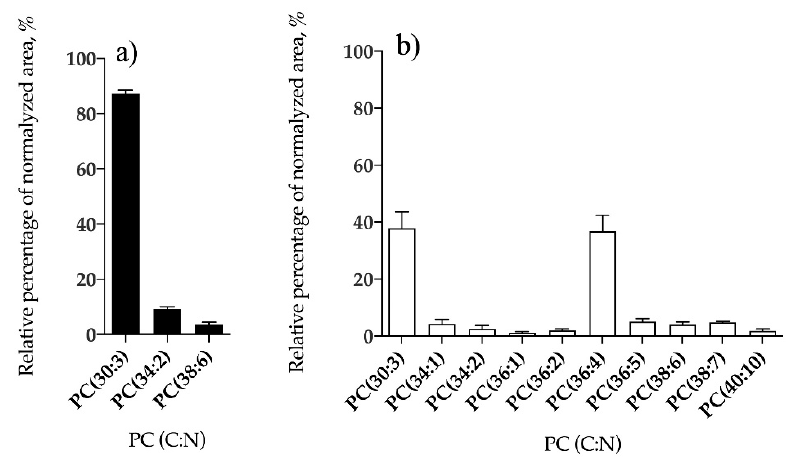
Figure 7. Relative abundance (RA) of lipid species of the phosphatidylcholine (PC) class identified in B. bifurcata ( a ) and S. muticum ( b ). The results are expressed as relative percentage after dividing the normalized peak area of each lipid species to the sum of normalized peak areas for all the lipid species within the class obtained after LC–MS analysis. Numbers in parentheses (C:N) indicate the number of carbon atoms (C) and double bounds (N) in the fatty acid side chains. The species with higher RA were PC (30:3) for B. bifurcata, and PC (30:3) and PC (36:4) for S. muticum .